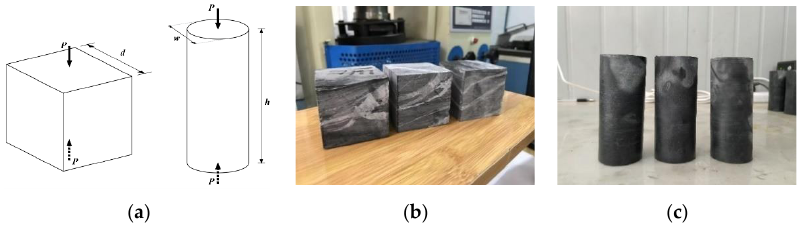
Figure 4. Carbonaceous slate UCS test samples: ( a ) UCS test sample loading direction; ( b ) cubic samples; ( c ) cylindrical samples. Note: d : Side length of cubic sample; w : Diameter of cylindrical sample; h : Height of cylindrical sample.